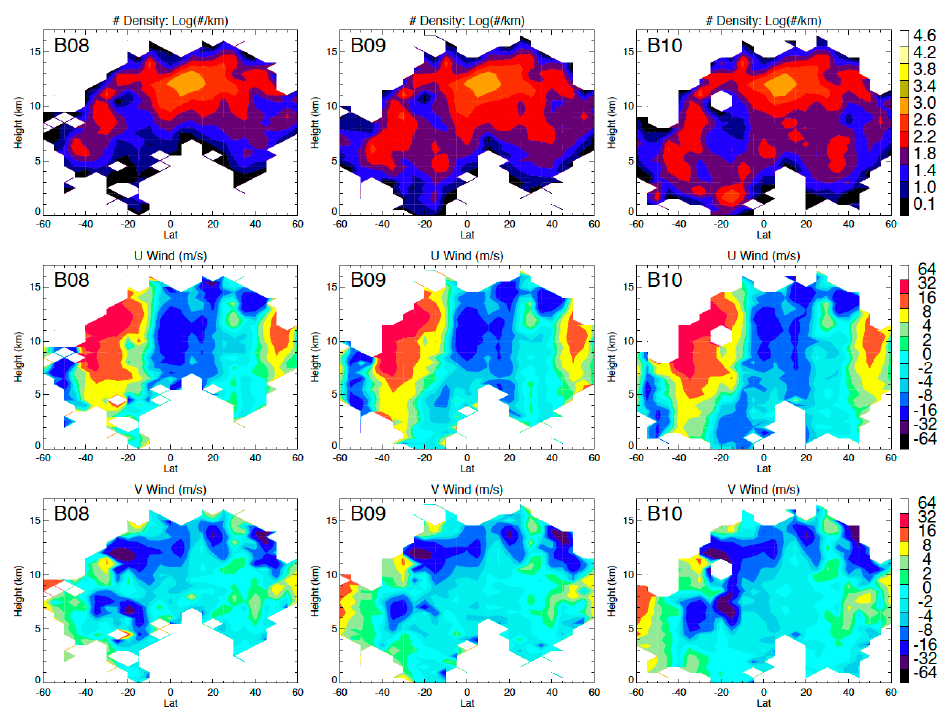
Figure 15. As in Figure 13 but for WV Bands 8–10. A template size of 24 × 24 was used for these stereo-wind retrievals.